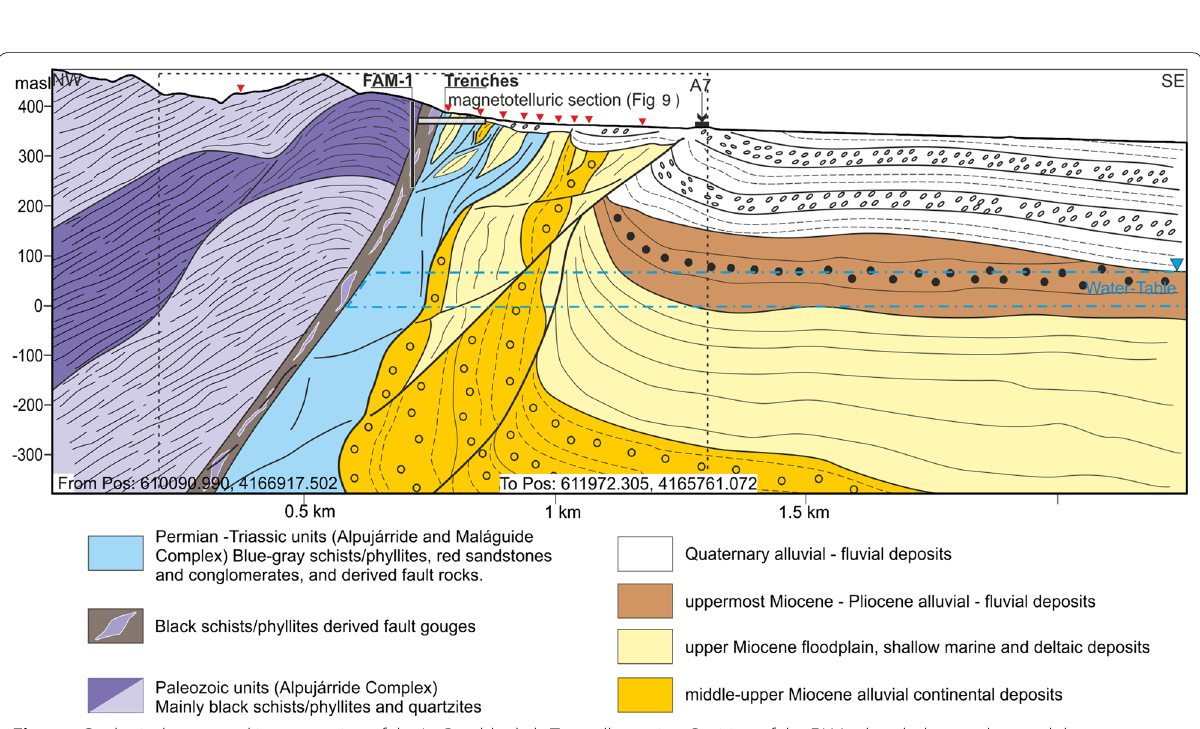
Fig. 11 Geological–structural interpretation of the La Rambla de la Torrecilla section. Position of the FAM‑1 borehole, trenches, and the geoelectrical section of Fig. 9 are projected for reference. Red triangles indicate the location of the magnetotelluric